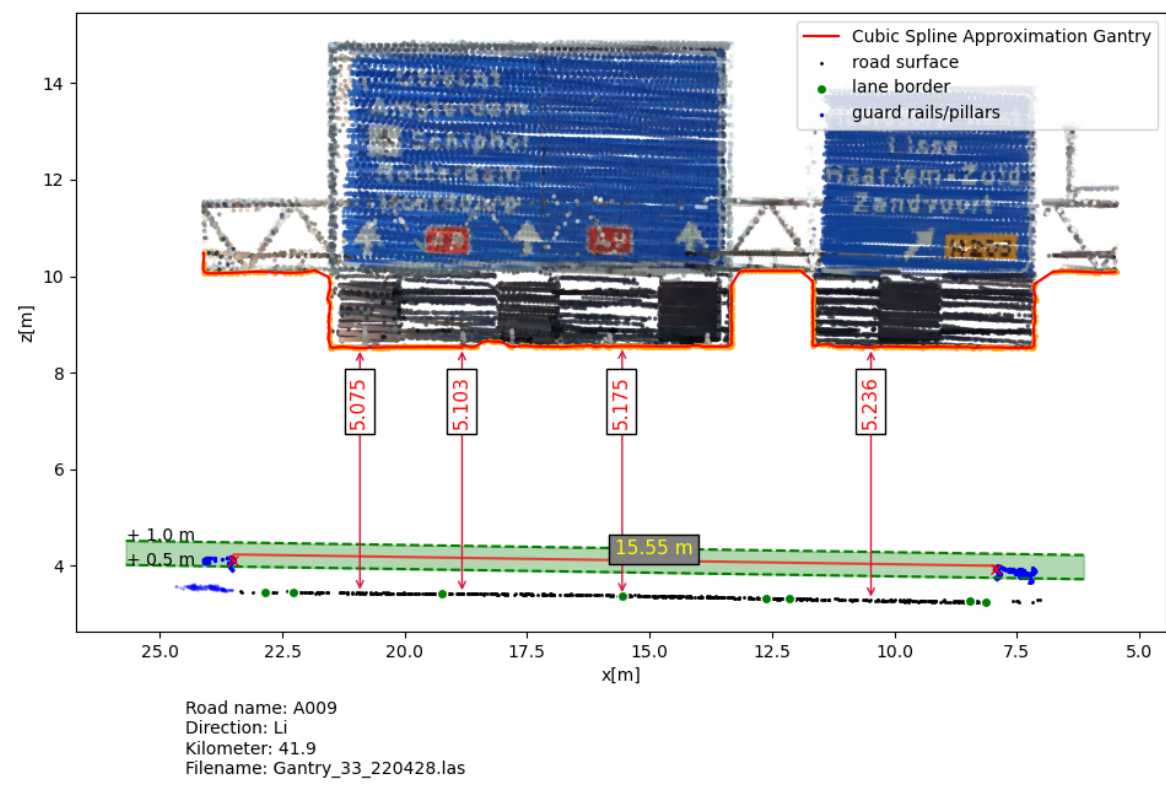
Figure 9. Example of the estimated clearances on a single gantry. The measurements are given in meters.